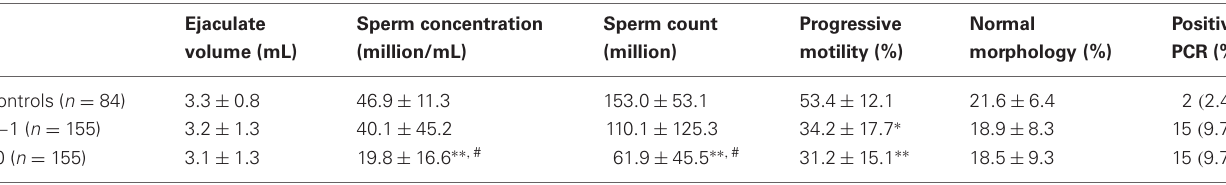
Table 1 | Sperm parameters and HPV DNA detection in semen samples from control subjects and patients at the time of diagnosis (T − 1) and 1 month after orchiectomy (T0).